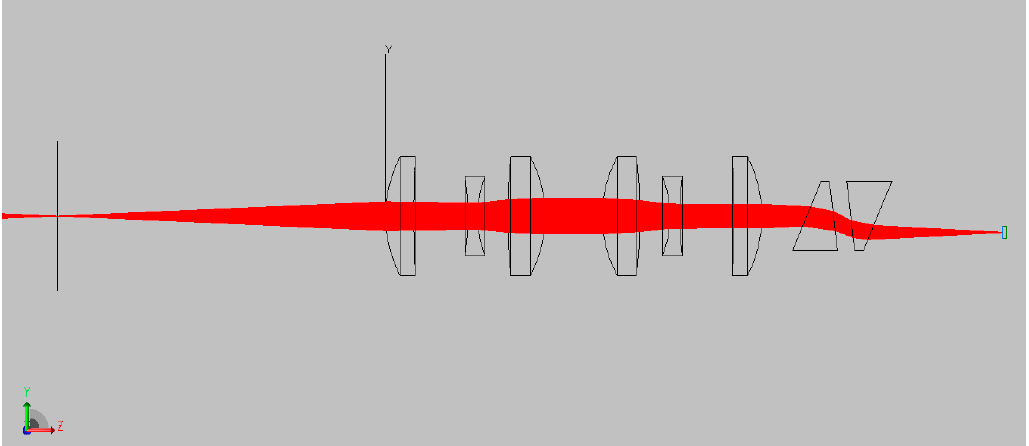
Figure 9. Ray diagram of the DP-CASSI showing how the 650 nm wavelength propagates through the coded aperture (far left), the six-element relay lens in the middle, the dual-prism, and the focal plane array (FPA, far right).